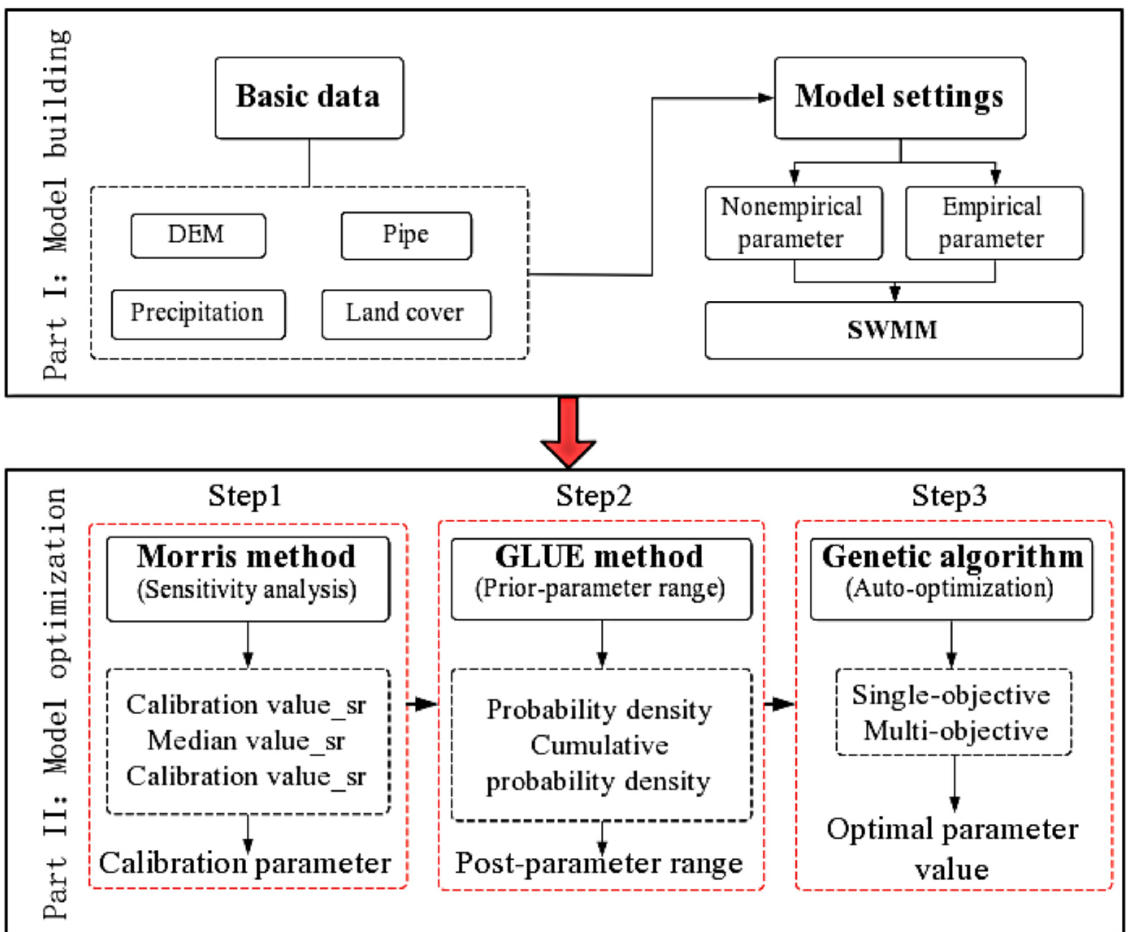
Figure 2. Flow chart of the research methods. The first step of the red dashed box symbolizes the process of identifying the parameters to be optimized, the second step depicts the process of narrowing the range of sensitive parameter values, and the third step represents the process of automatic model parameter optimization utilizing the Genetic Algorithm.